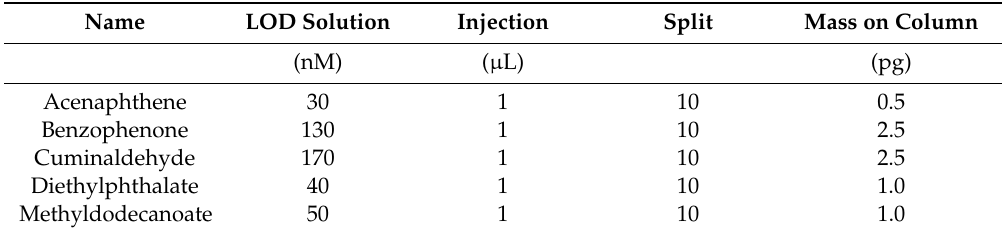
Table 1. Limit of detection (LOD) of the standards determined by the Kaiser and Specker